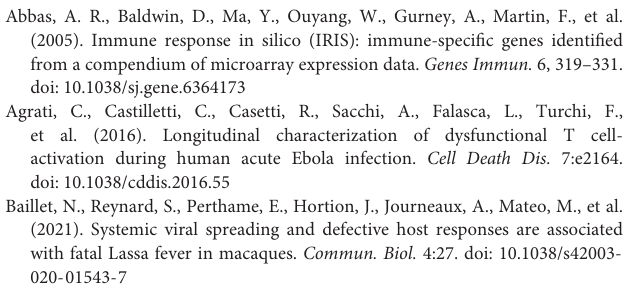
Supplementary Figure 4 | STEM analysis of EBOV-Makona isolates. Gene expression graphs depicting the STEM clusters identified for EBOV-Makona (A) Guinea C07, (B) Mali, and (C) Liberia. GO term enrichment heatmaps for (D) cluster 0 and (E) cluster 1. Color intensity represents the statistical significance [shown as the − log( q -value)] with the range of colors based on GO terms with the lowest and highest significance statistic for the entire set of GO terms per cluster. The number of genes enriching to each GO term per column is represented in each box; white boxes indicate no statistical significance. (F) GO term bar graphs representing enrichment of genes in cluster 3. Horizontal bars represent the number of genes mapping to each GO term, while color intensity represents the − log( q -value) value of the corresponding GO term. Panels (D–F) follow the color key in plots A–C: cluster 0, red; cluster 1, blue; and cluster 2, orange. Supplementary Figure 5 | Analysis of genes identified by MaSigPro, two-way forward regression analysis for EBOV-Makona and EBOV-Mayinga isolates. Heatmaps of genes identified by MaSigPro for (A) cluster 1, (B) cluster 2, (C) cluster 3, and (D) cluster 4. The latter was split into two sub-clusters: cluster 4A containing genes that were upregulated only in response to Liberia isolate and cluster 4B containing genes downregulated by all isolates. Select genes are indicated. Each column represents the median RPKM of all animals at a given day post infection. Red presents upregulated; blue represents downregulated. Range of colors is based on scaled and centered rpkm values of the represented DEGs. Supplementary Table 1 | Statistical analysis (adjusted p -values) of longitudinal changes in cell and platelet populations. Adjusted p -values for data in Supplementary Figure 3 . Two-way ANOVA with Geisser-Greenhouse correction to account for unequal variability of differences. Significant values highlighted in red. DPI, days post